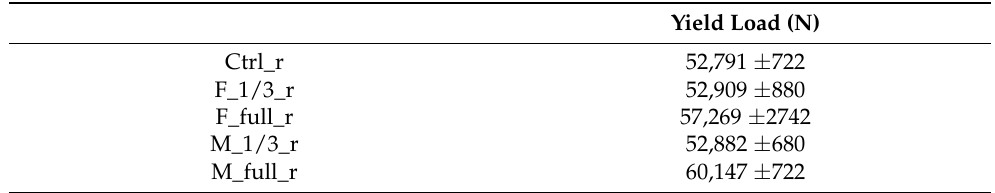
Table 7. Yield strength of the RC beams post repeated